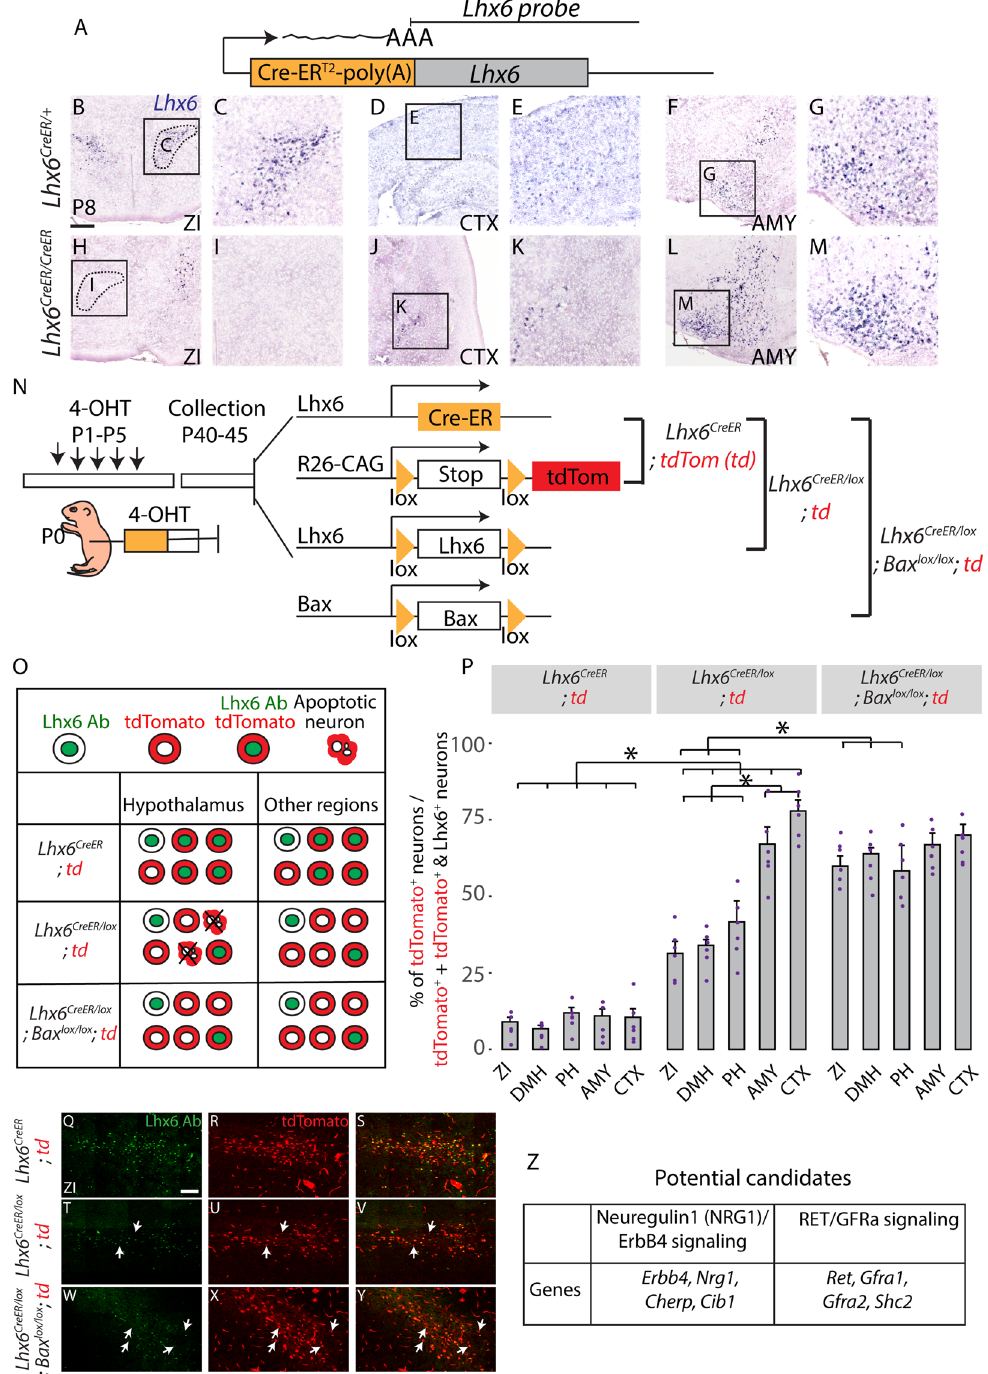
Fig. 2 Lhx6 in the hypothalamus is necessary for neuronal survival. A Lhx6 CreER knock-in site (JAX #010776) and location of the Lhx6 probe used to detect read-through transcription. B – M Coronal planes showing Lhx6 mRNA expression in the zona incerta (ZI, B , C , H , I ), amygdala (AMY, F , G , L , M ), and cortex (CTX, D , E , J , K ) in control ( Lhx6 CreER/ + , B – G ) and mutant ( Lhx6 CreER/CreER , H – M ) at P8. Note Lhx6 mRNA is not detected in the Lhx6-de fi cient hypothalamus but is detected in the telencephalon. N Schematic diagram showing the overall design of the experiment from three genotypes (1. Lhx6 CreER/ + ;Ai9 , 2. Lhx6 CreER/lox ;Ai9 , 3. Lhx6 CreER/lox ;;Bax lox/lox ;Ai9 ). O Schematic diagram showing the overall outcome of the experiment. P A bar graph showing the percentage of tdTomato + / (tdTomato + and tdTomato + /Lhx6 + ) across three genotypes in fi ve different brain regions. *Indicates p <0.05. DMH dorsomedial hypothalamus, PH posterior hypothalamus. Q – Y Representative images of three genotypes (1. Lhx6 CreER/ + ;Ai9 ( Q – S ), 2. Lhx6 CreER/lox ;Ai9 ( T – V ), 3. Lhx6 CreER/lox ;Bax lox/lox ;Ai9 ( W – Y ) in ZI. More images of different brain regions are available in Supplementary Fig. 1. Z Potential candidate genes from bulk RNA-Seq (Supplementary Fig. 2) controlling cell survival can be regulated by Lhx6 in hypothalamic Lhx6 + neurons: Neuregulin-ErbB4 signaling and Gdnf signaling pathways (Supplementary Figs. S3, S4). Scale bar = 0.6mm ( B – M ), 100 μ m ( Q – Y ). All bar graphs ( P ) show mean and standard error of the mean (SEM), with individual data points plotted.